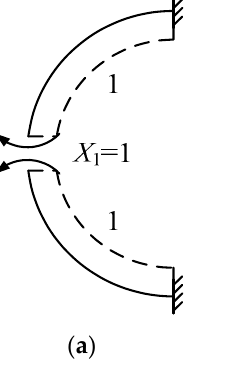
Figure 2. Basic system for internal force calculation of pressurized water conveyance tunnel.